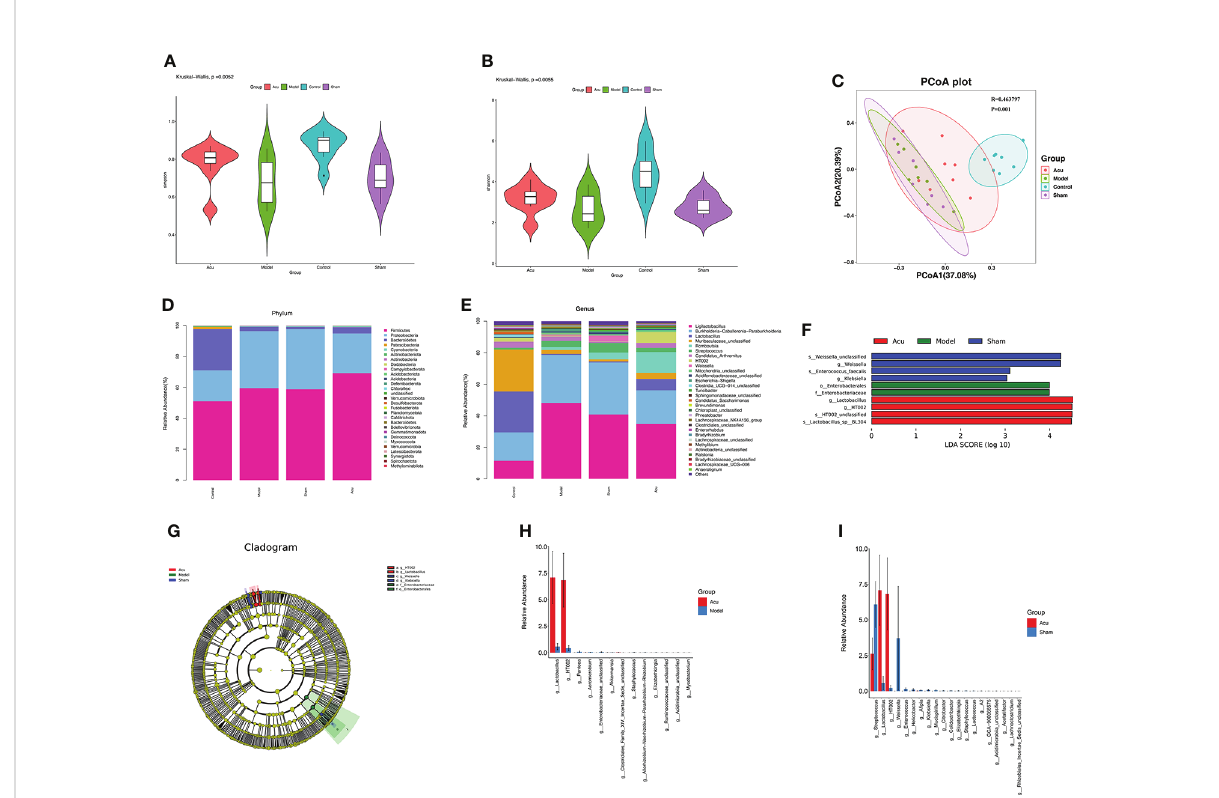
FIGURE 2 Acupuncture treatment modulates species ’ abundance of gut microbiota of CRF mice after chemotherapy for BC. (A, B) The Shannon index ( P =0.0052) and the Simpson index ( P =0.0055) of acupuncture treatment on species richness and diversity were signi fi cantly different. (C) The PCoA data showed that the b -diversity between the acu group and the control group was more similar than that between the model group, the sham group and the control group ( P =0.001, R=0.463797). (D) At the phylum level, phyla abundance changes in each group. (E) At the phylum level, the genus abundance changes in each group. (F, G) LEfSe analysis showed the community composition and species abundance in the acu, model and sham group. (H, I) The histogram shows the relative abundance of the different genera between the acu group and the model group and between the acu group and the sham group at the genus